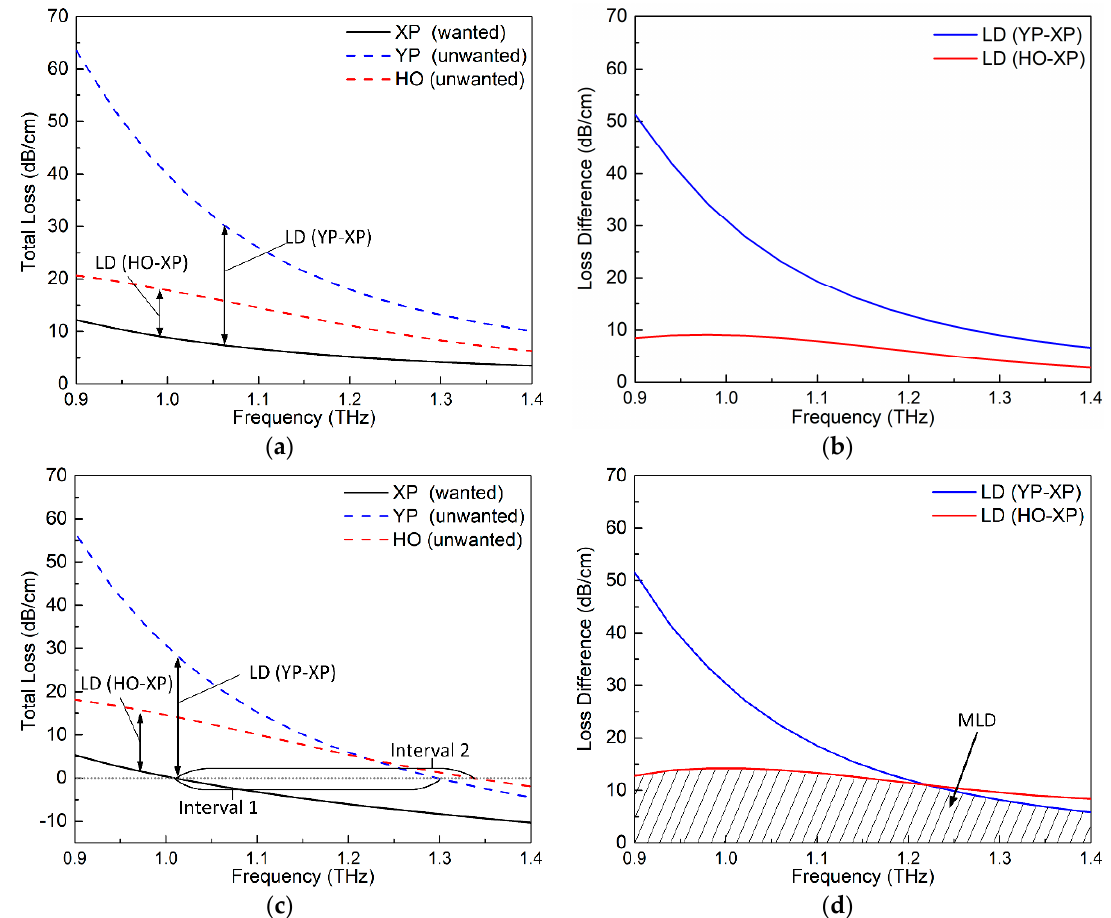
Figure 3. Simulated SPSM PCF results. ( a ) total losses (TLs) and ( b ) loss differences (LDs) of the passive version. ( c ) TLs and ( d ) LDs of the active version.